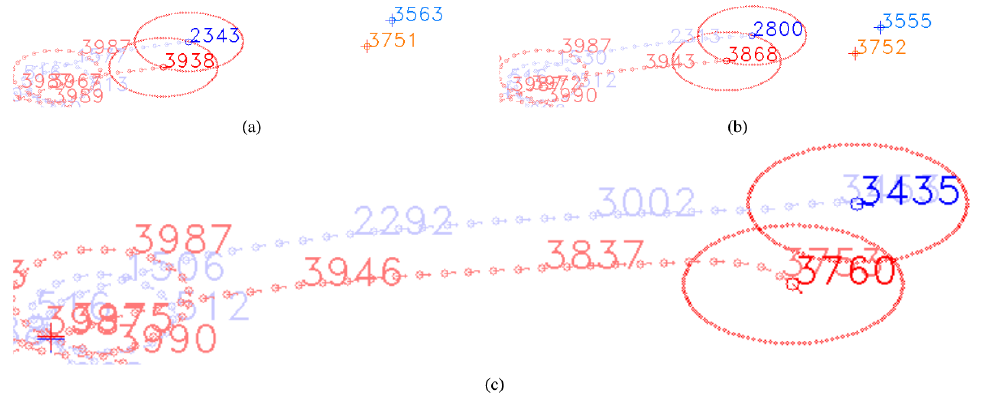
Figure 7. Example of the working principle of the algorithm with visualization of a dynamic environment. The red circles show the UAV’s safety zone. The numerical values in the figures show the height of each UAV. ( a ) First detection of a long-distance collision of two UAVs flying in almost parallel trajectories. ( b ) Slight target waypoints adjustment after 30 iterations. The trajectories are corrected for the first time. ( c ) The end of the collision avoidance maneuver with visible target points. A change in the trajectory of each UAV is